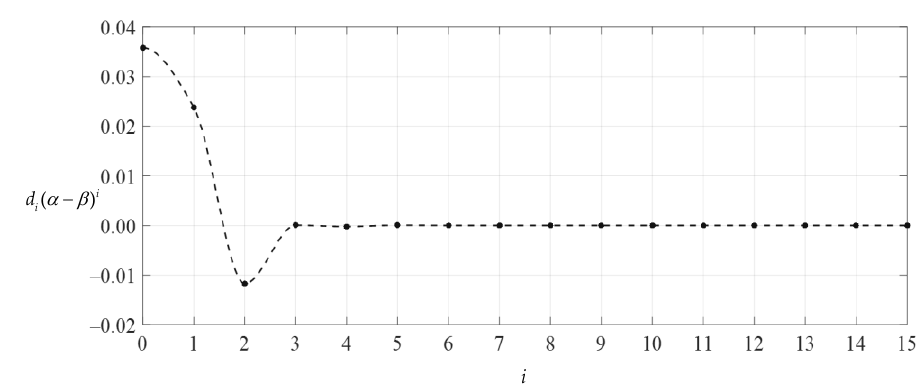
Figure 9 . Variation of d i (1 − β ) i with i .